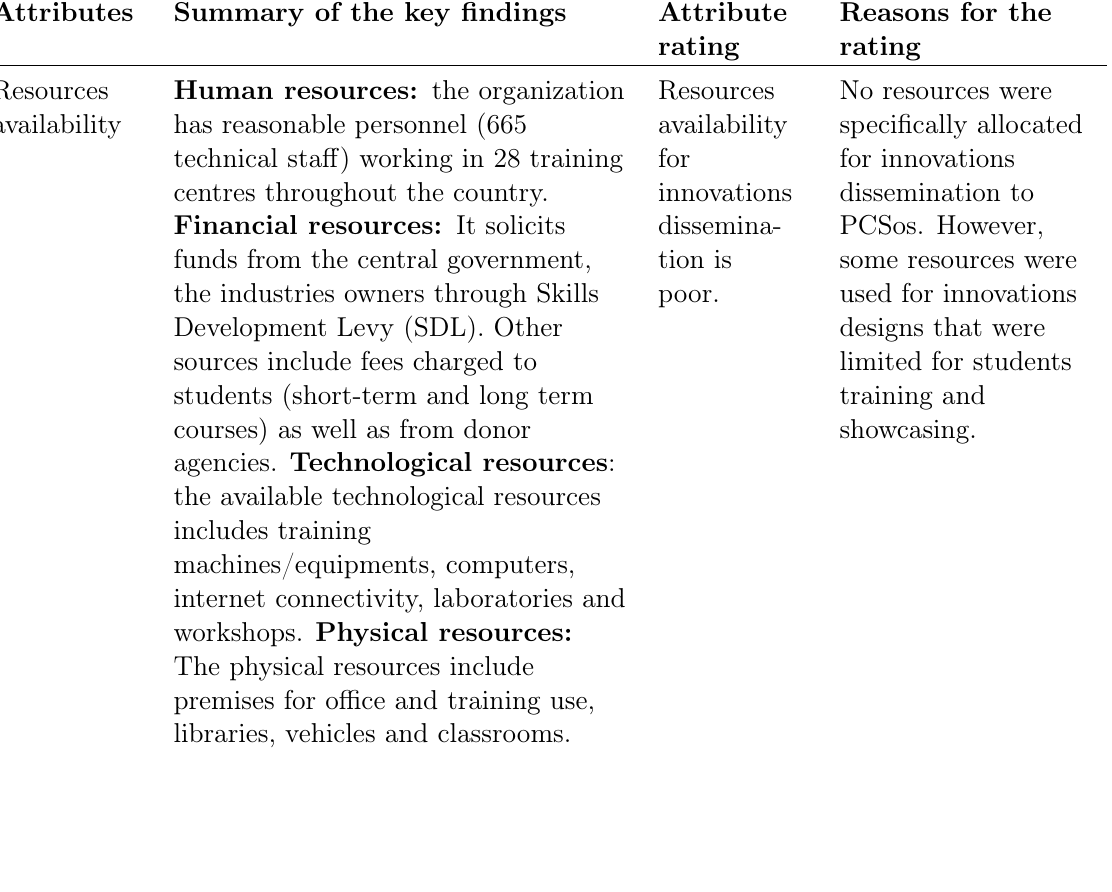
Table 3. VETA resources capability attributes Attributes Summary of the key